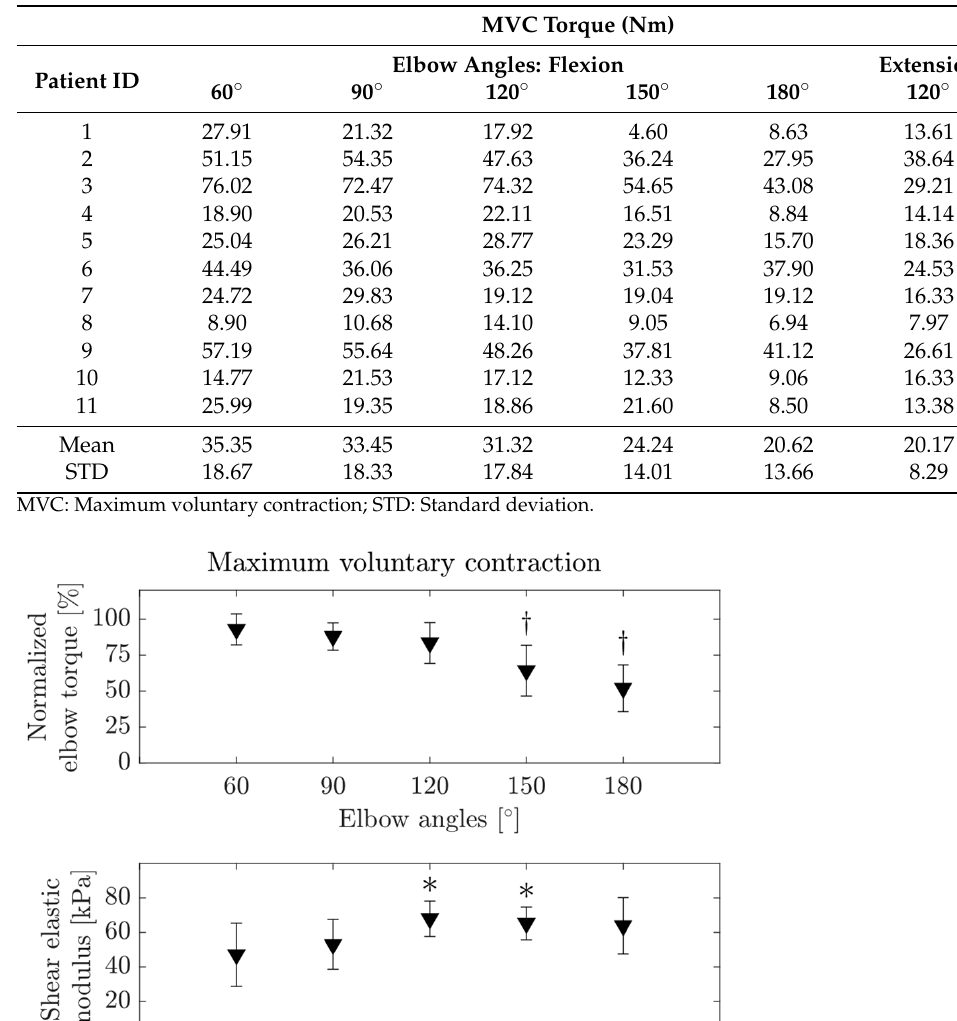
Table 3. Individual maximum elbow torque during maximum voluntary contraction (MVC) in flexion and extension directions.